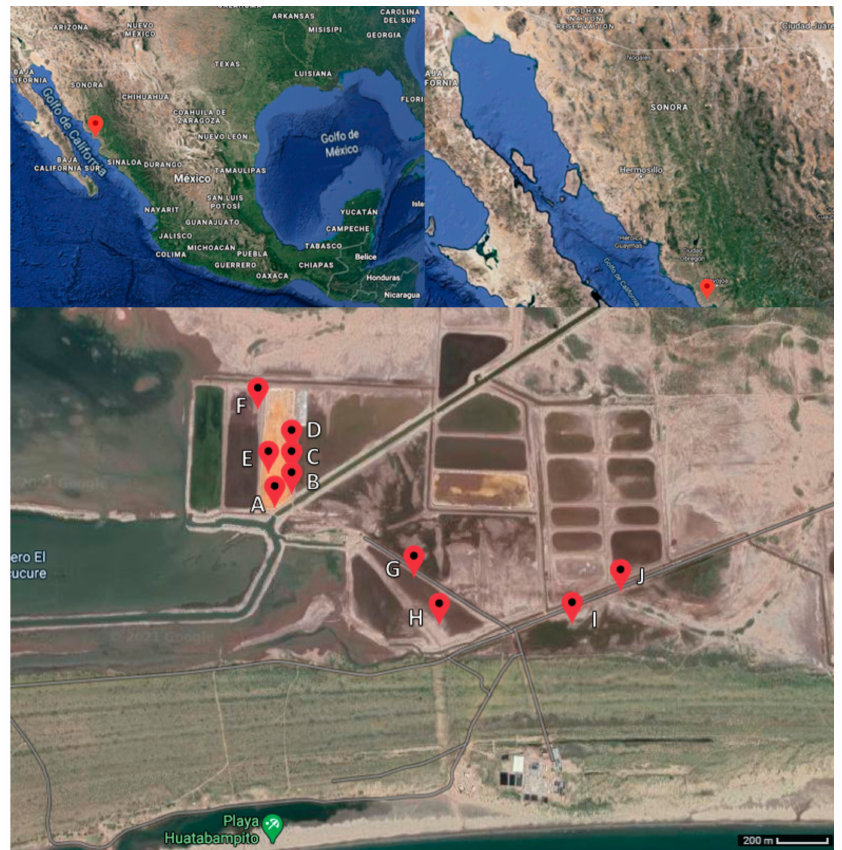
Figure 1. Maps of Huatabampo municipality in M é xico, in the Sonora State, and of the Santa B á rbara saltern, showing the 10 sampling points (A: N26 ◦ 42.421 (cid:48) W109 ◦ 38.510 (cid:48) ; B: N26 ◦ 42.444 (cid:48) W109 ◦ 38.475 (cid:48) ;